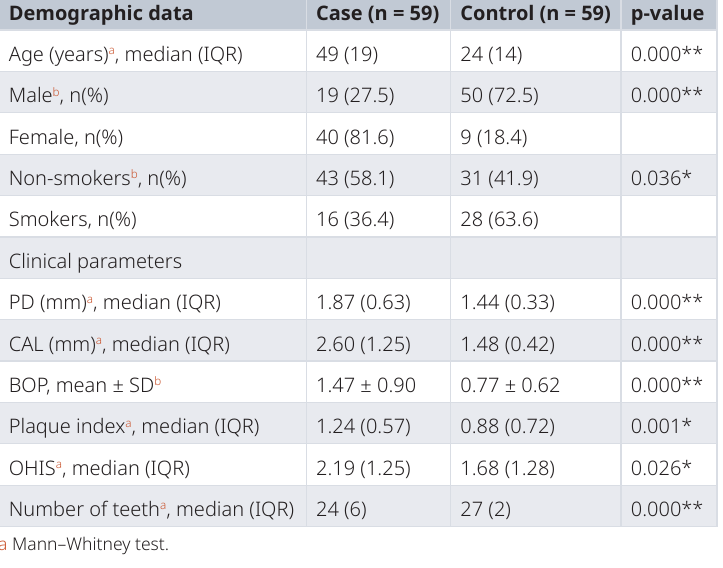
Table 1. Demographic data and clinical